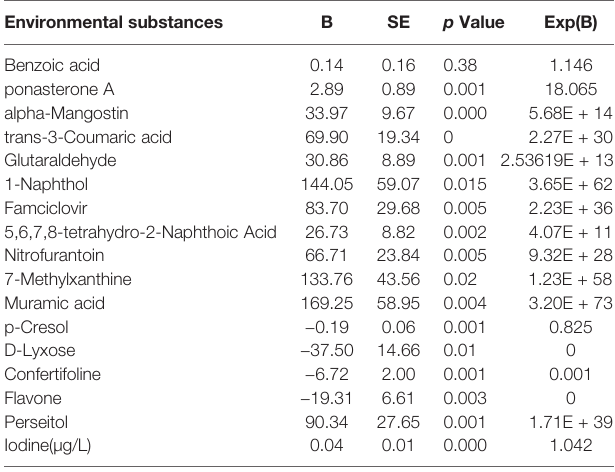
TABLE 3 | The univariate logistic analysis of the relationship between environmental substances and GD onset.